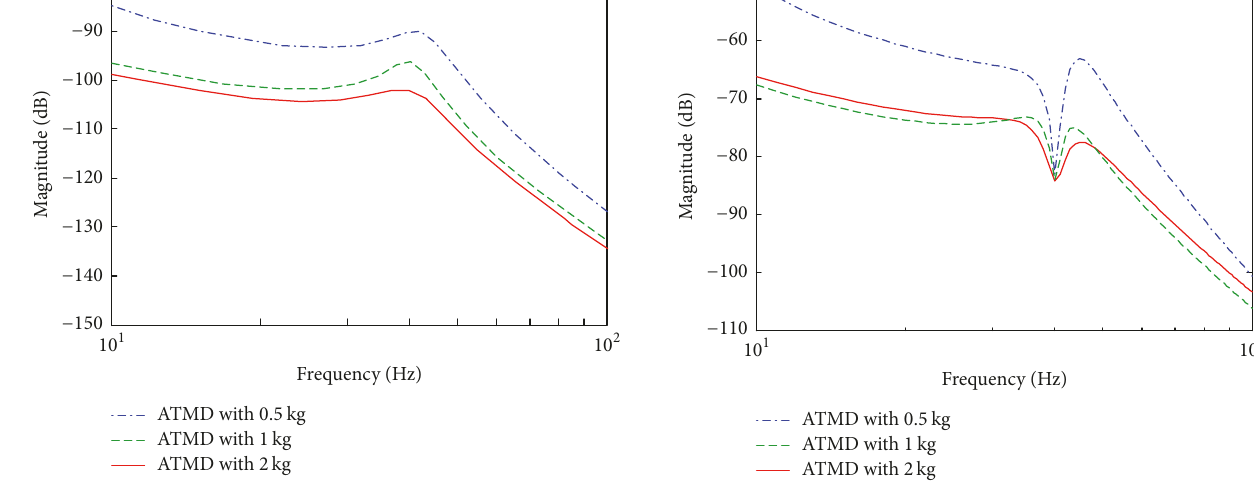
Figure 9: Stroke of the ATMDs for three different masses.